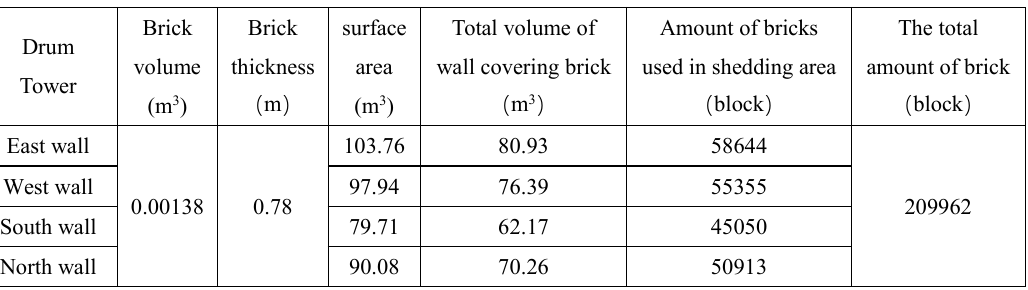
Table 3 The amount of bricks used in the falling area of the wall of Puzhou Drum